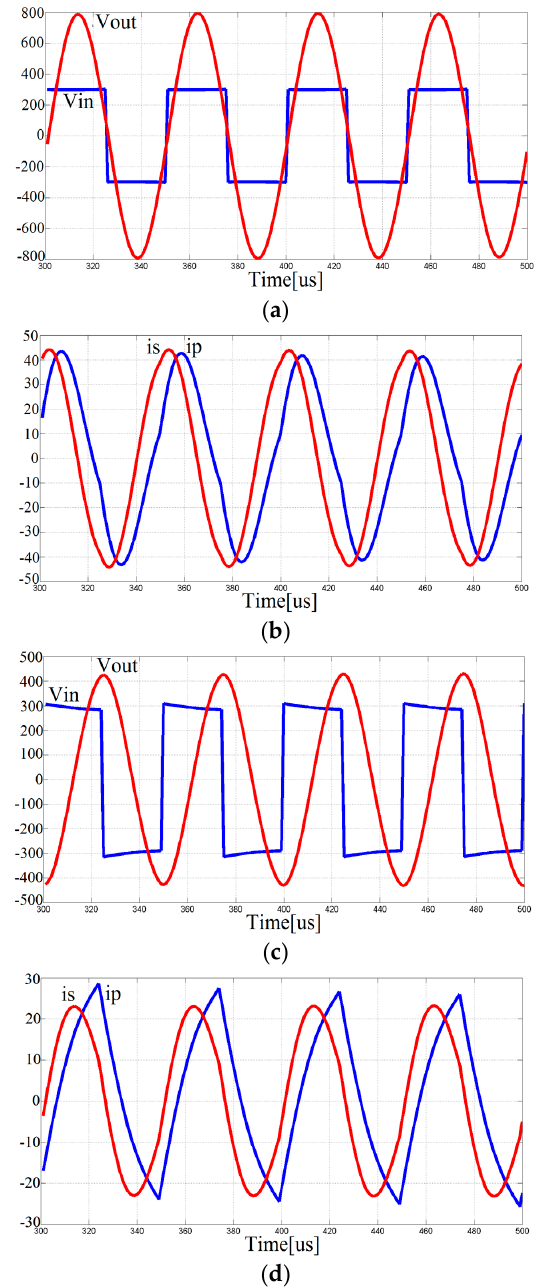
Figure 12. Waveforms of the IPT system based on finite element analysis (V dc : 300 V; fsw: 20 kHz; air gap: 150 mm). ( a ) Input and output voltages of SP topology; ( b ) Input and output currents of SP topology; ( c ) Input and output voltages of P topology; ( d ) Input and output currents of P topology.